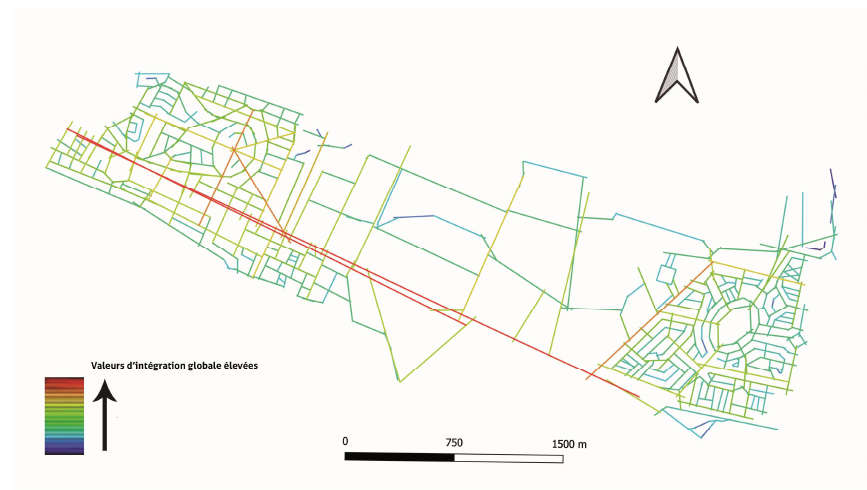
Figure 7. Local Integration (R3) map of Hammem Chott.